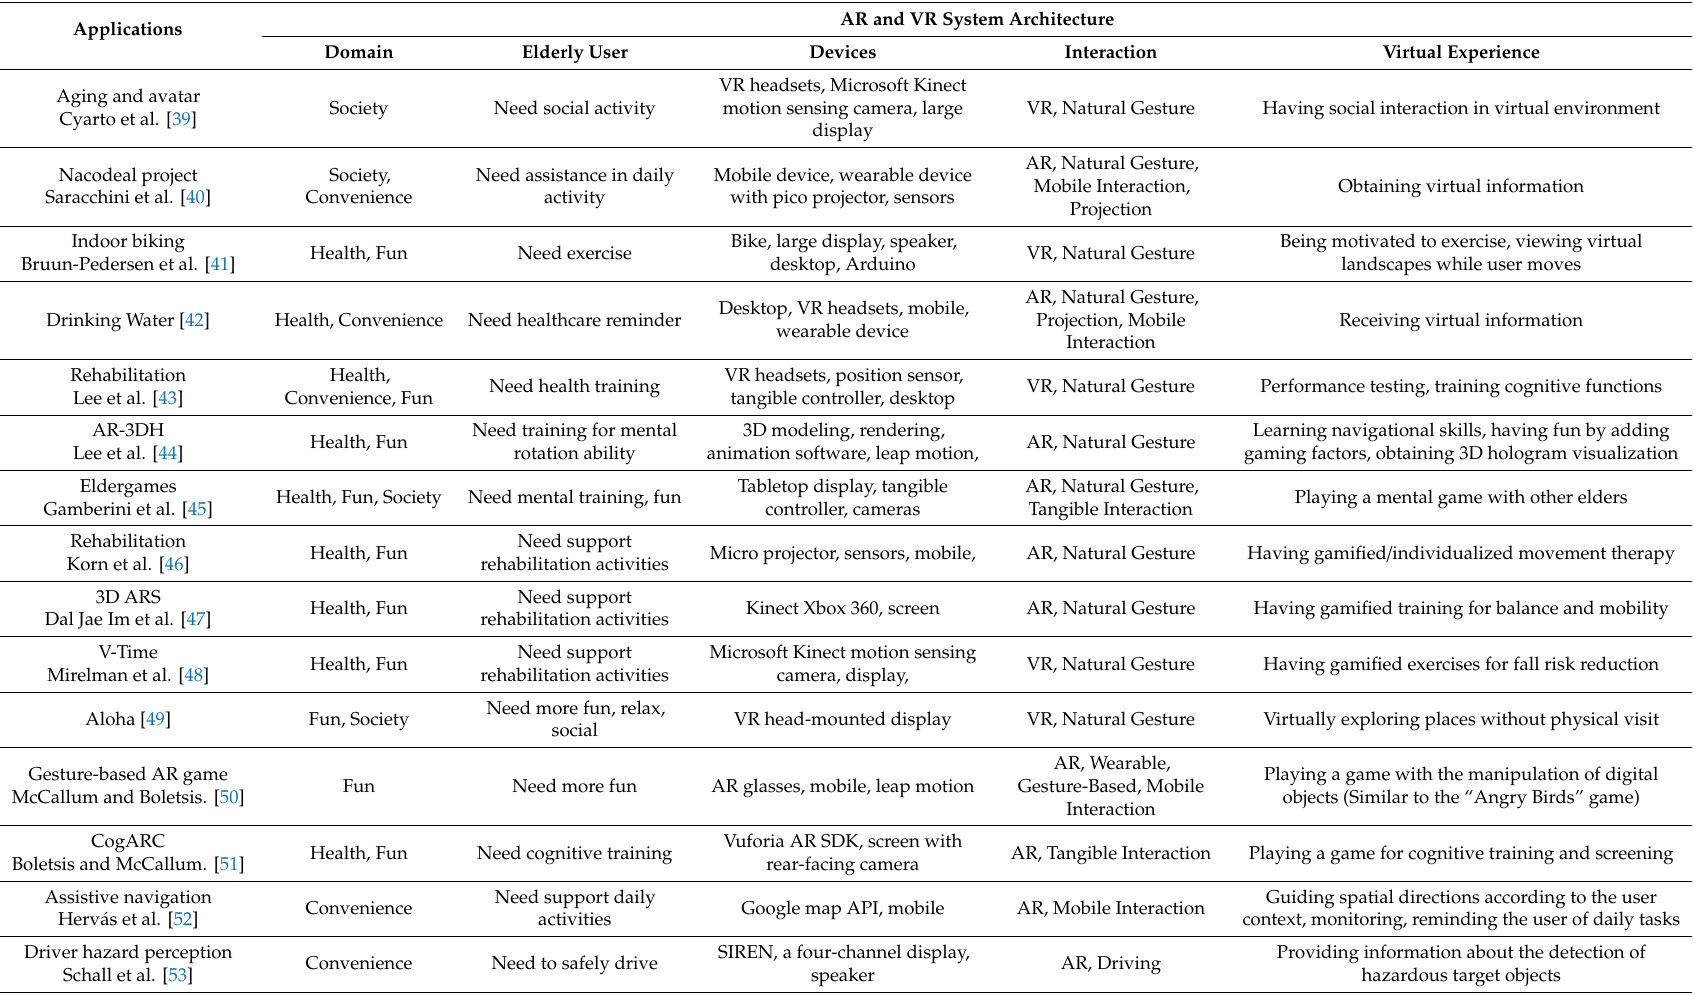
Table 1. Contextual analysis of Augmented reality (AR) and virtual reality (VR) factors from each